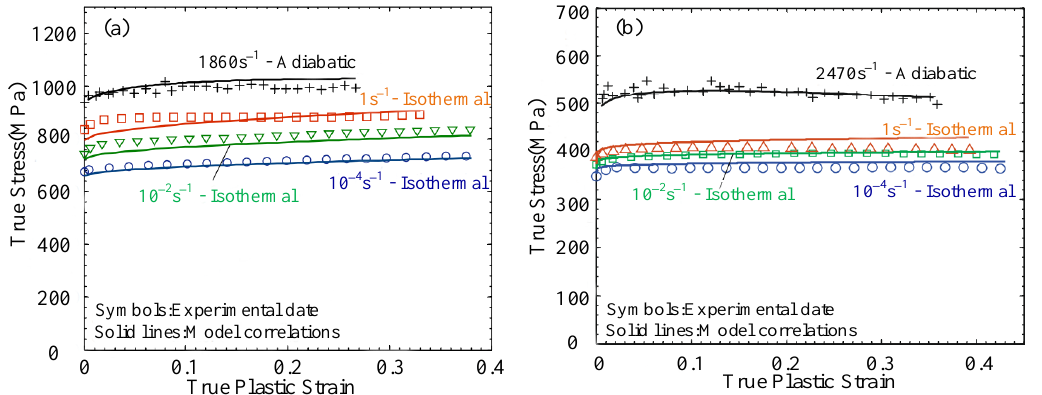
Figure 9. Prediction results of the KLF model under different mean particle sizes [21], ( a ) Cu; ( b ) Al.